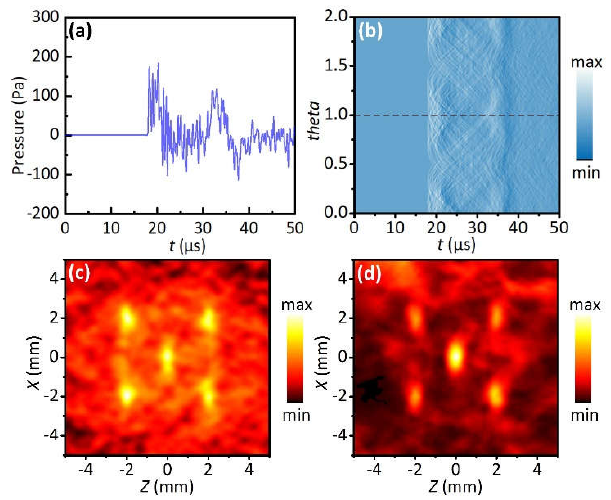
Figure 3. Simulative results. ( a ) The detected photoacoustic (PA) signals by a single transducer. ( b ) The detected PA signals by all transducers. ( c ) The image reconstructed by the delay and sum (DAS) beamforming method. ( d ) The image reconstructed by the proposed matrix filtering method.